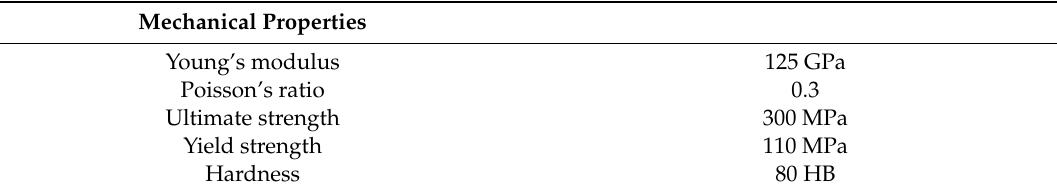
Figure 1. ( a ) Test specimen and main dimensions; ( b ) Wall thinning defect sizes. Table 1. Material properties.